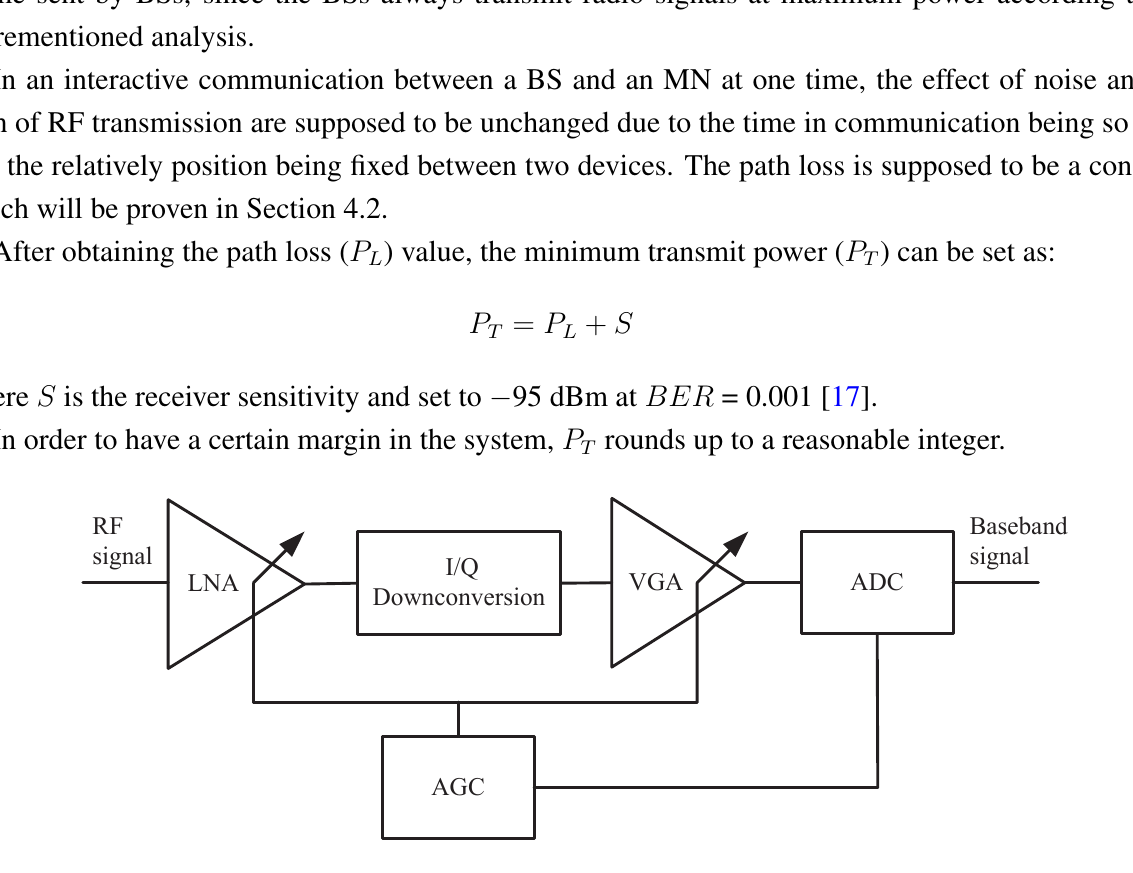
Figure 4. Block diagram of the nanoLOC receiver chain with automatic gain control